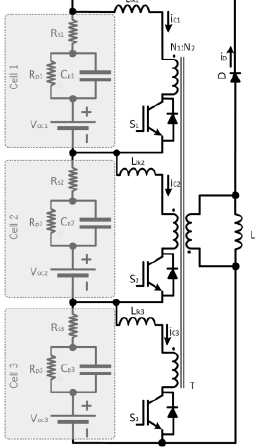
Figure 19. Multi-winding transformer converter.